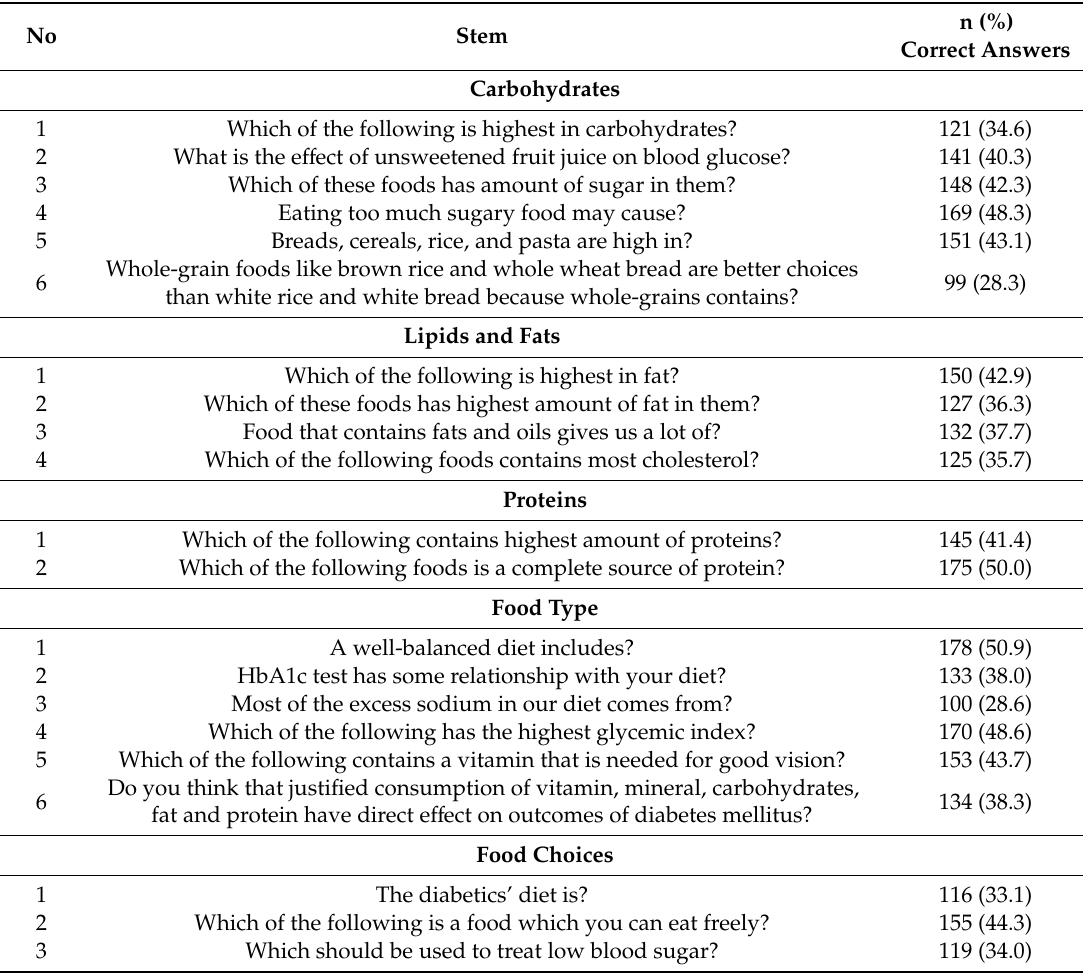
Table 3. Sub-groups of dietary